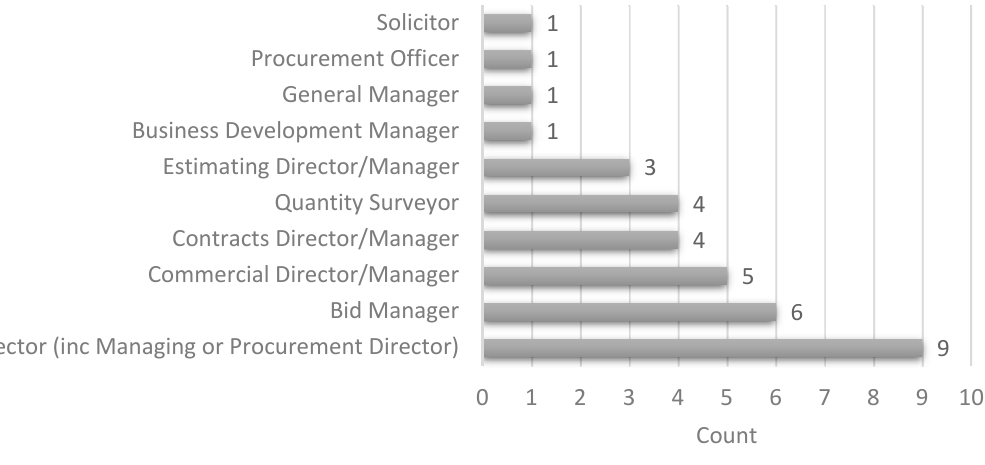
Figure 7. Respondents by size of organisation they represent.